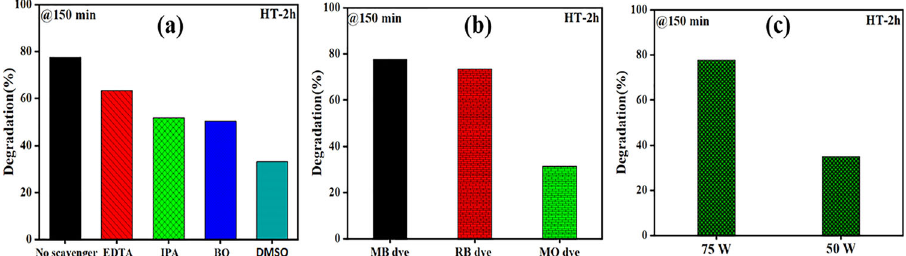
Fig. 7 Piezocatalytic performance under various scavengers, dyes, and ultrasonication power. The piezocatalytic dye degradation (%) performance of HT-2h sample using a various scavengers, b various dyes, and c different ultrasonication power.